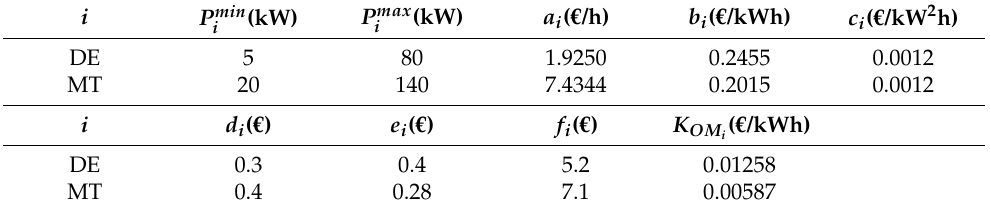
Table 3. The coefficients of the generator cost functions.